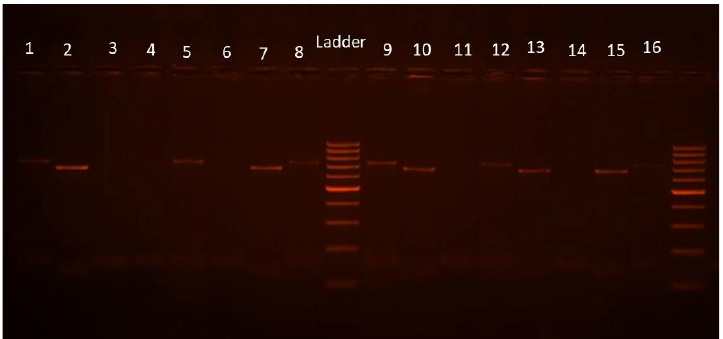
Figure 4. Diagnostic PCR using the primers set for P. falciparum and P. vivax . 1: positive control P. falciparum (395 bp); 2: positive control P. vivax (499 bp); 3: negative control; 4 – 39: samples; Ladder = 100 bp (Solis BioDyne).